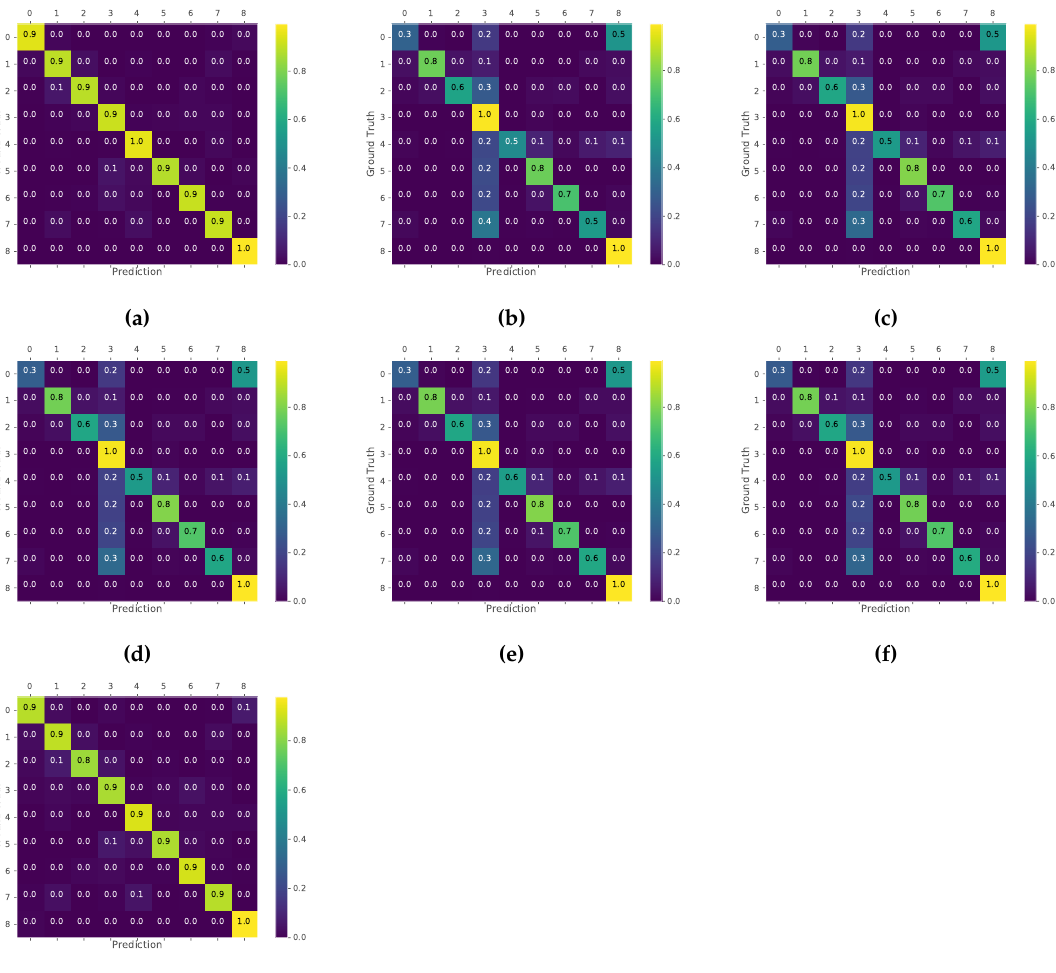
Figure 5. Confusion matrix of disease classification using high-resolution, low-resolution, and super-resolution images with magnification scale 2. Values are normalized by the number of elements in each class. Numbers on x and y axes indicate the ID of diseases in Table 1. ( a ) Original; ( b ) Bilinear; ( c ) Cubic; ( d ) Bicubic; ( e ) Lanczos; ( f ) NearestNeighbor; ( g )